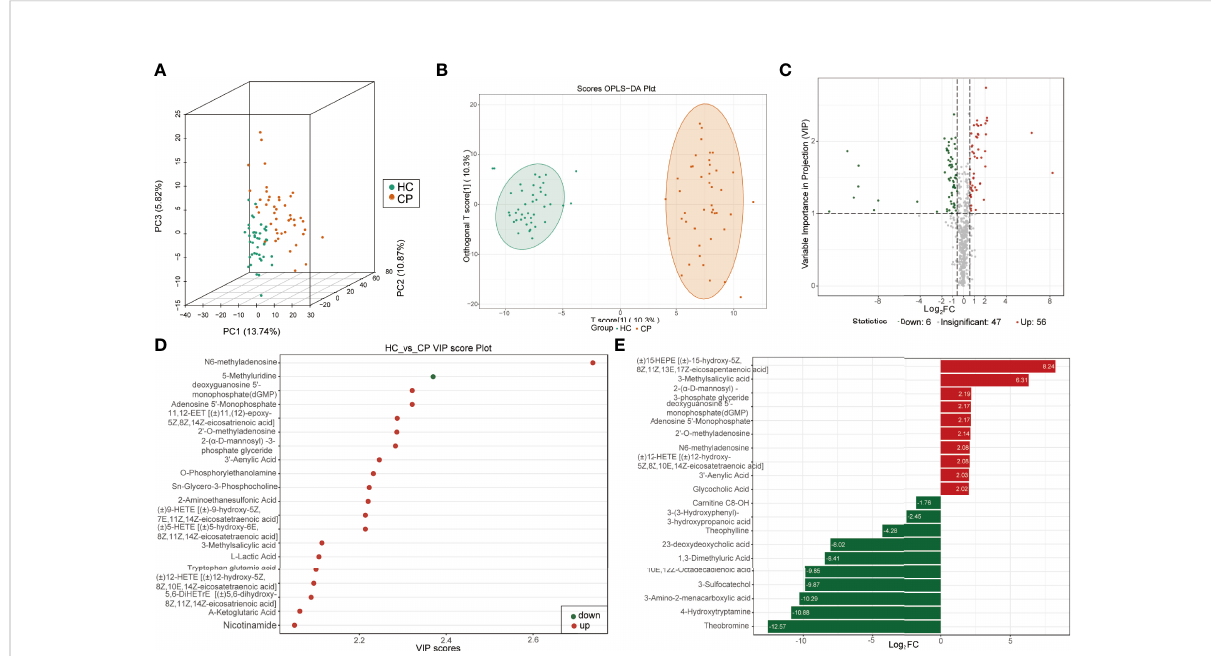
FIGURE 1 Identi fi cation of differentially expressed metabolites between COVID-19 patients and healthy controls. (A) Score plots of three-dimension principal component analysis (3D-PCA) discriminating between the metabolic pro fi les of healthy controls (HC) and COVID-19 patients (CP). (B) Orthogonal partial least-squares discriminant analysis (OPLS-DA) score plot of HC and CP. (C) Volcanic map of differentially expressed metabolites between HC and CP. Red dots represent upregulated metabolites, gray dots represent unchanged metabolites, and green dots represent downregulated metabolites. (D) The top 20 differentially expressed metabolites ranked by the value importance plot (VIP). (E) The top 20 differentially expressed metabolites ranked by the log 2 fold change (Log 2